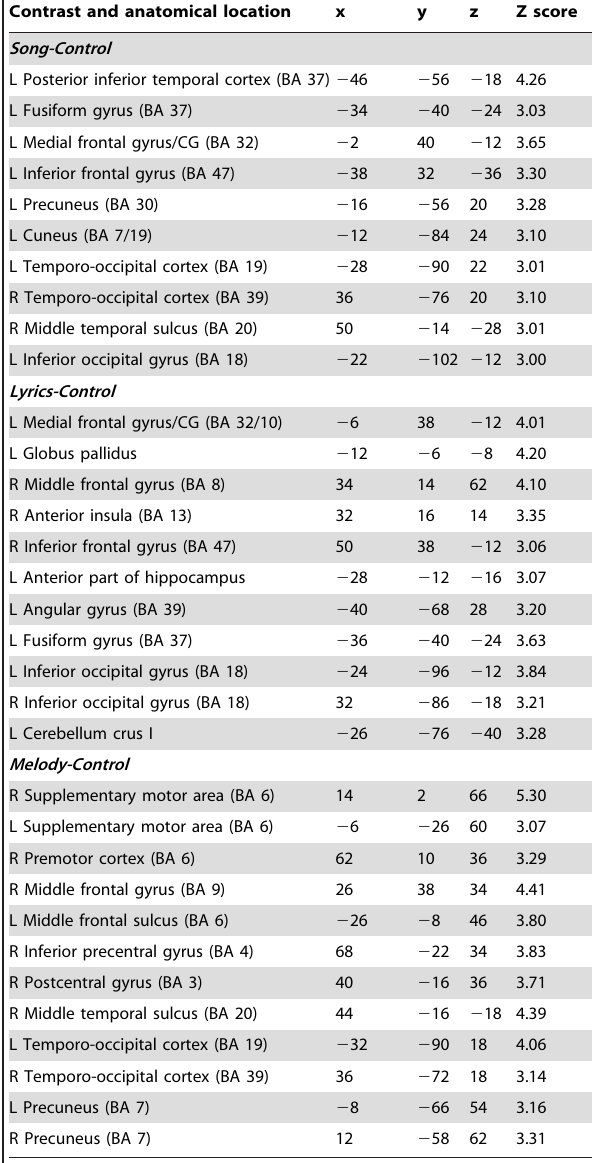
Table 1. Brain regions activated by the three familiarity decision conditions more strongly than by the control condition.